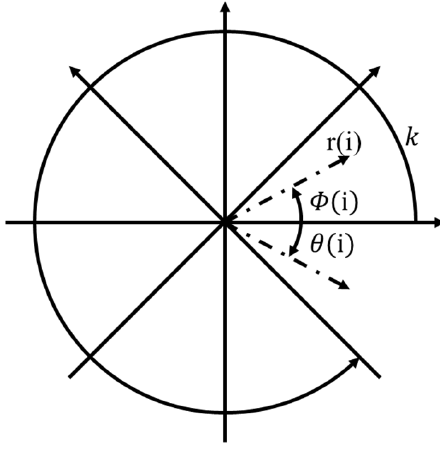
Figure 2. Schematic diagram of the SDP operation .